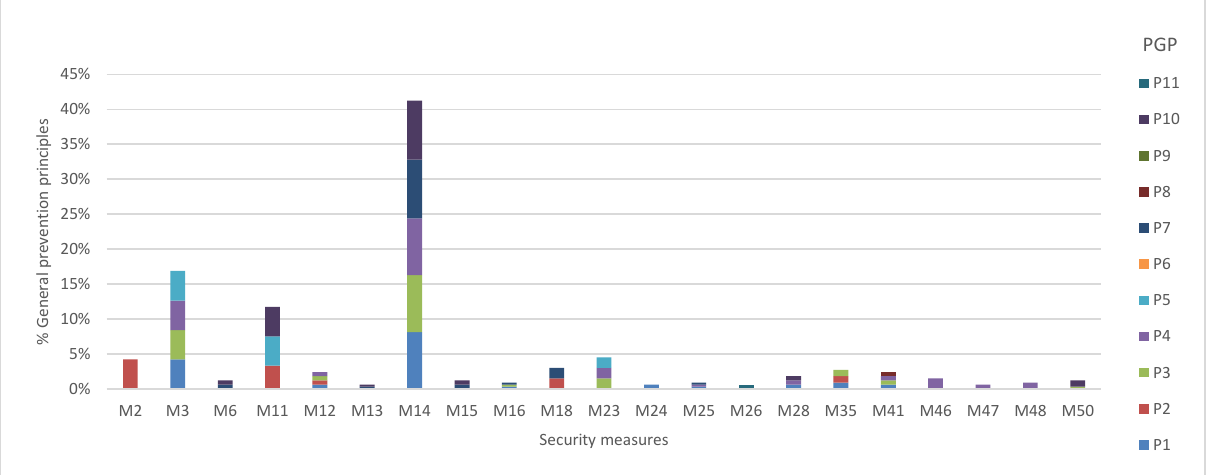
Figure 13. General prevention principles distribution associated to the safety